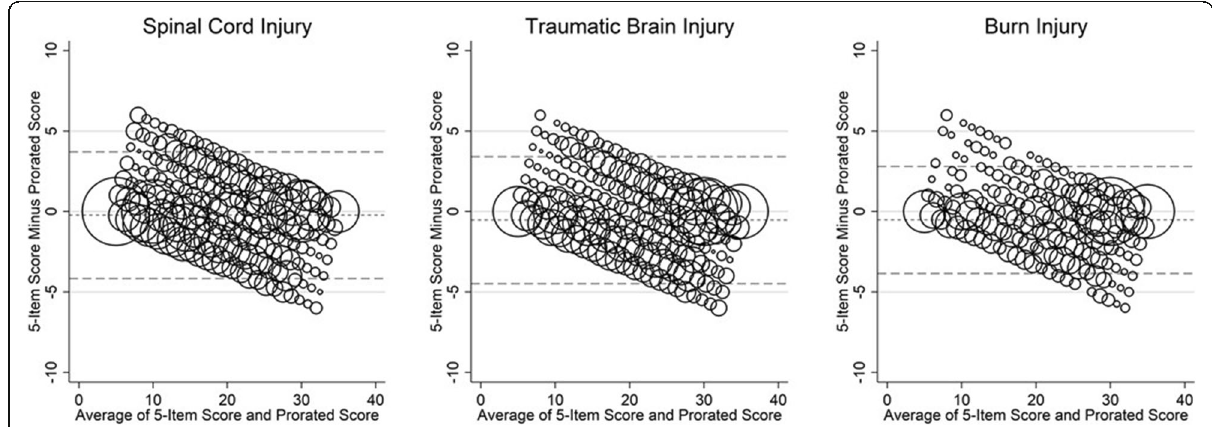
Fig. 1 Bland-Altman plots for agreement between directly derived and prorated SWLS scores within each injury group. The small dotted line represents the mean difference between the scores and the large dashed lines represent the 95% limits of